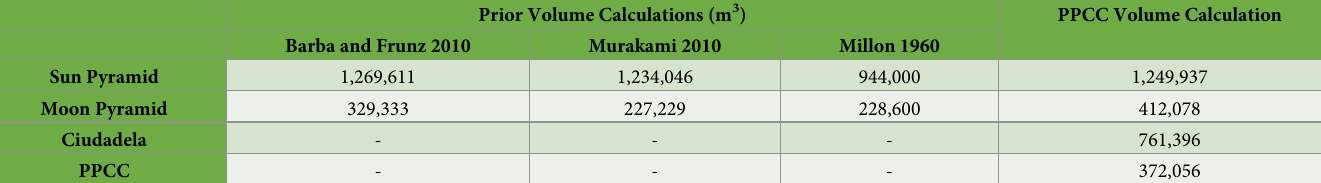
Table 3. Volume calculations of the Moon Pyramid, Sun Pyramid, and Ciudadela/Feathered Serpent